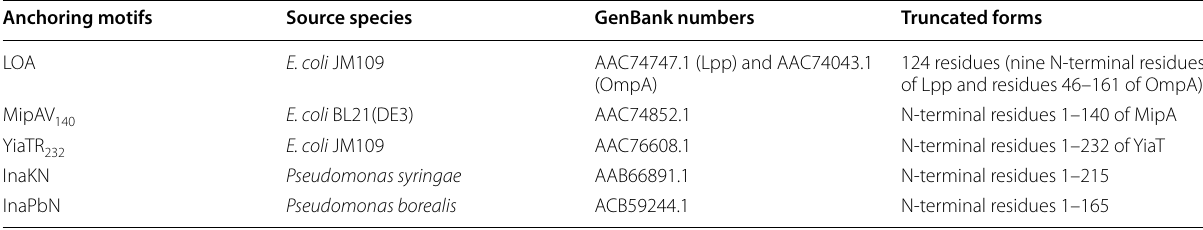
Table 2 Anchoring motifs used in this study Anchoring